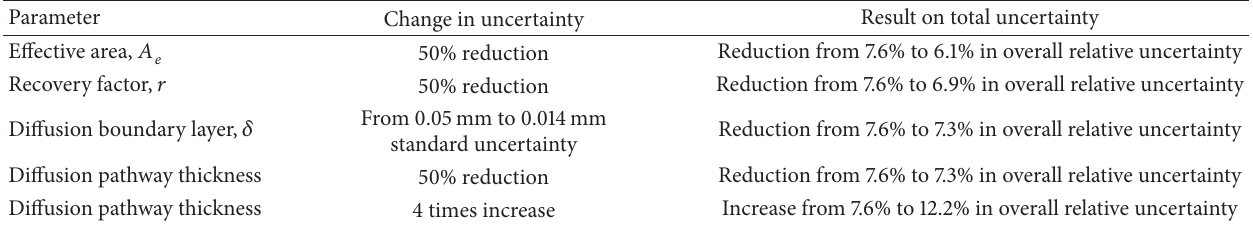
Table 6: Results from sensitivity analysis, showing the effect on total uncertainty of the passive sampler measurement from reductions in uncertainty of selected